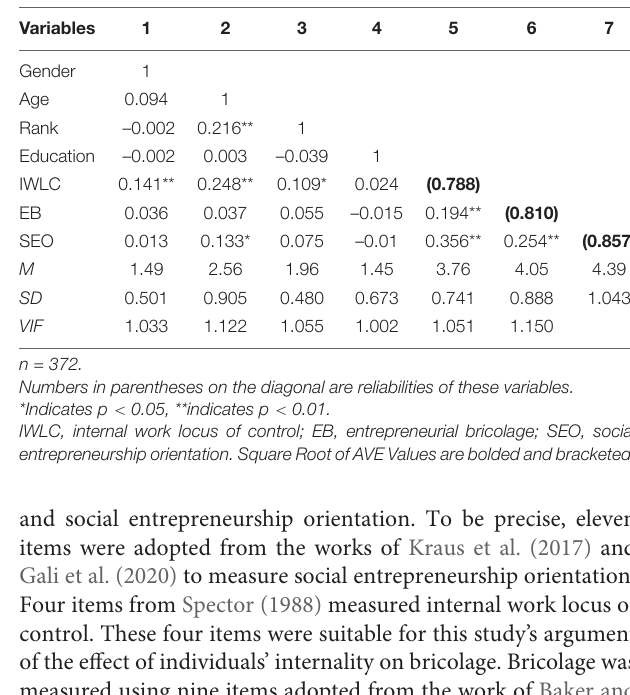
TABLE 2 | Means, standard deviations, and correlations of variables.